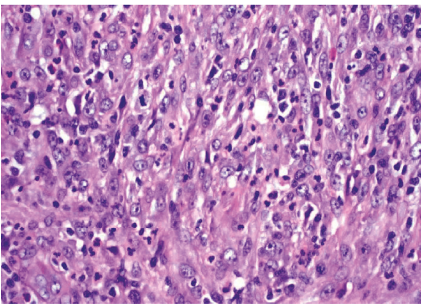
Figure 2: Effaced inguinal lymph node with spindled and epi- thelioid cells with eosinophilic cytoplasm. Large pleomorphic nuclei with abundant nucleoli.